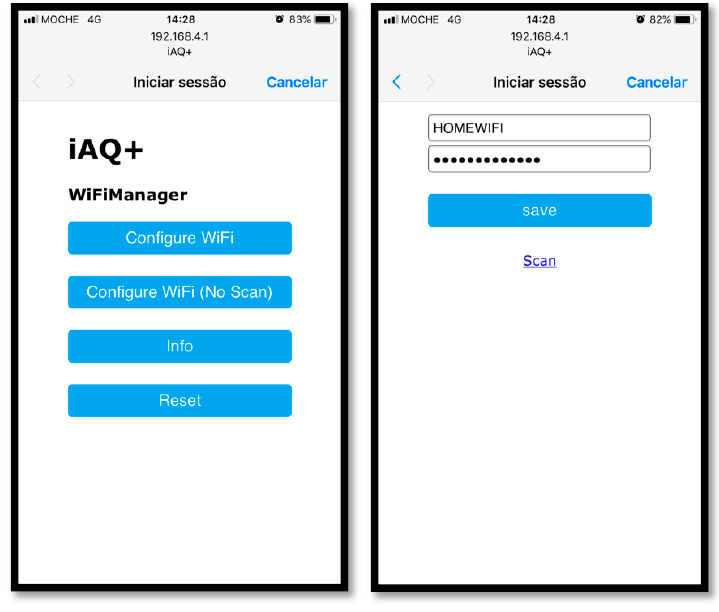
Figure 10. Wi-Fi configuration.